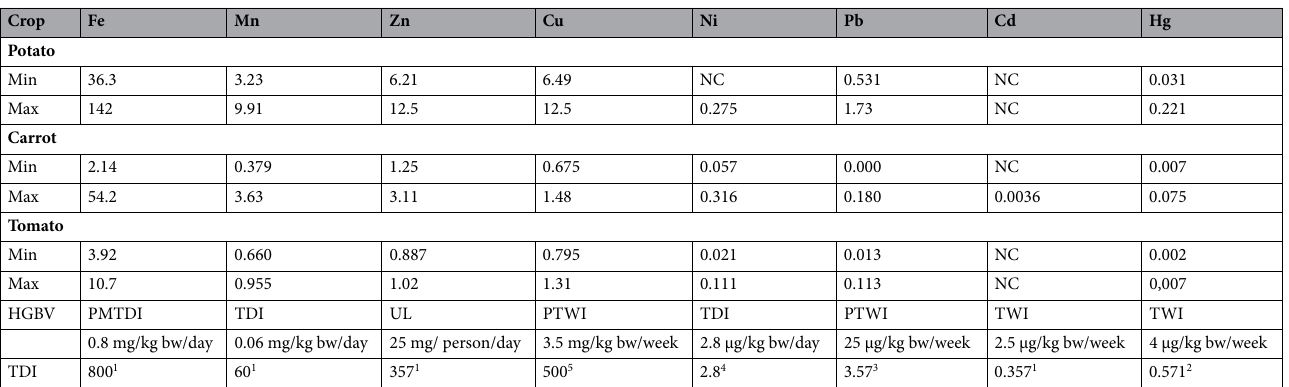
Table 11. Estimated daily intake (EDI, μg/day kg bw) and Tolerable daily intake (TDI, μg/day kg bw). Bw body weight, NC not calculated, HGBV health-based guidance values, PMTDI provisional maximum TDI, UL tolerable upper intake level, TWI tolerable weekly intake, TDI tolerable daily intake, PTWI provisional tolerable weekly intake, HGBV(Zn) recalculated from pregnant and lactating women. 1 According to EFSA 83 .